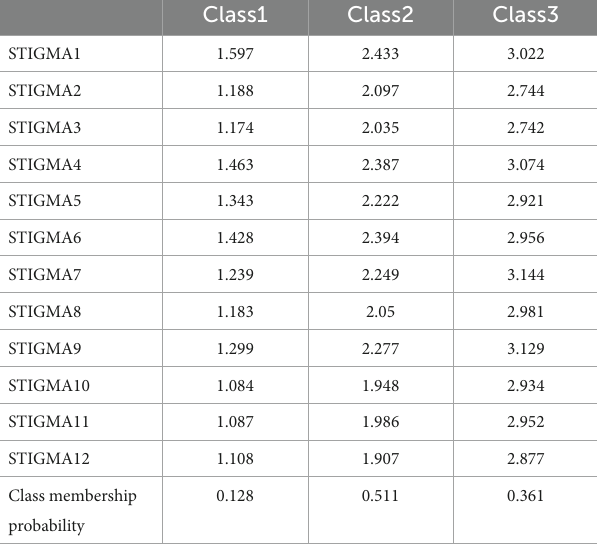
TABLE 4 Conditional means of items of CSS-S on each class. TABLE 5 Average latent class probabilities for most likely latent class membership by latent